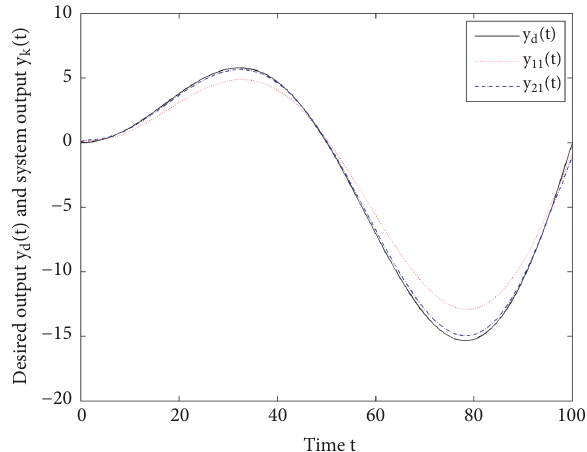
Figure 3: The output trajectories of the ILC system (27) and (28) for 𝑡 ∈ {0,1, .. ., 100} at iterations 𝑘 = 11 and 𝑘 = 21 .